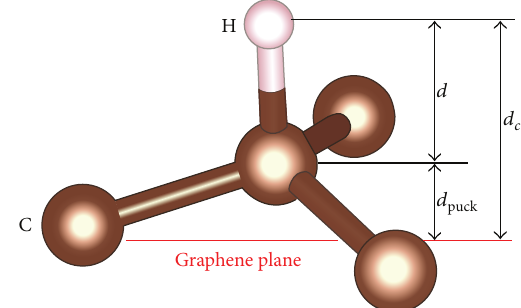
Figure 2: The geometrical and structural parameters to quantify deformation in the chemisorption state. Table 1: Comparison with previous works of the distance between the hydrogen atom and the bonded carbon atom ( 𝑑 ), the outside plane distance of the bonded carbon atom ( 𝑑 ( 𝐸 𝐵 ), and chemisorption energy ( 𝐸 𝑐